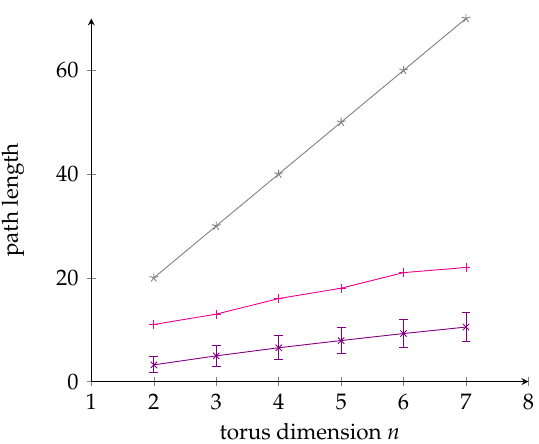
Figure 8. Empirical evaluation: average and maximum (with standard deviation) path lengths of the paths selected by the proposed algorithm in a T ( n ,5 ) .